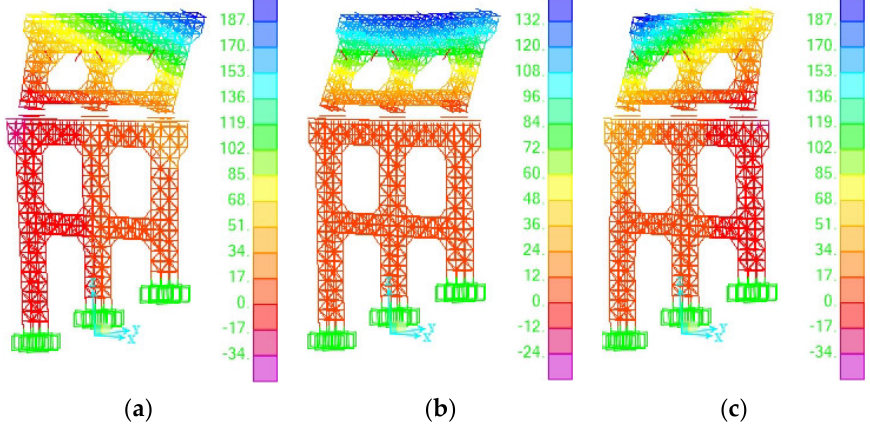
Figure 10. Deformation of tower at right bank (unit: mm): ( a ) Load 1; ( b ) Load 2; ( c ) Load 3.